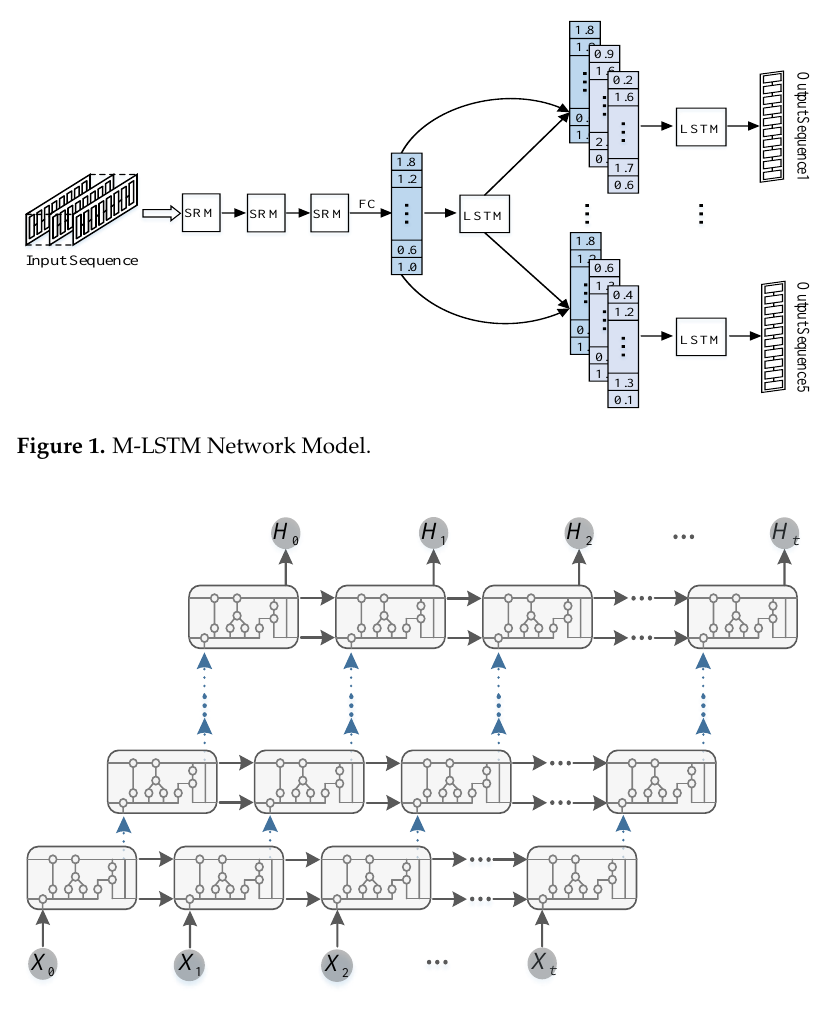
Figure 2. Schematic diagram of the deep LSTM structure.